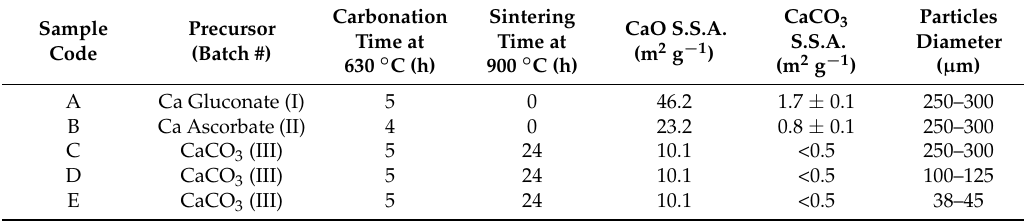
Table 1. Characteristics of the samples prepared from three different